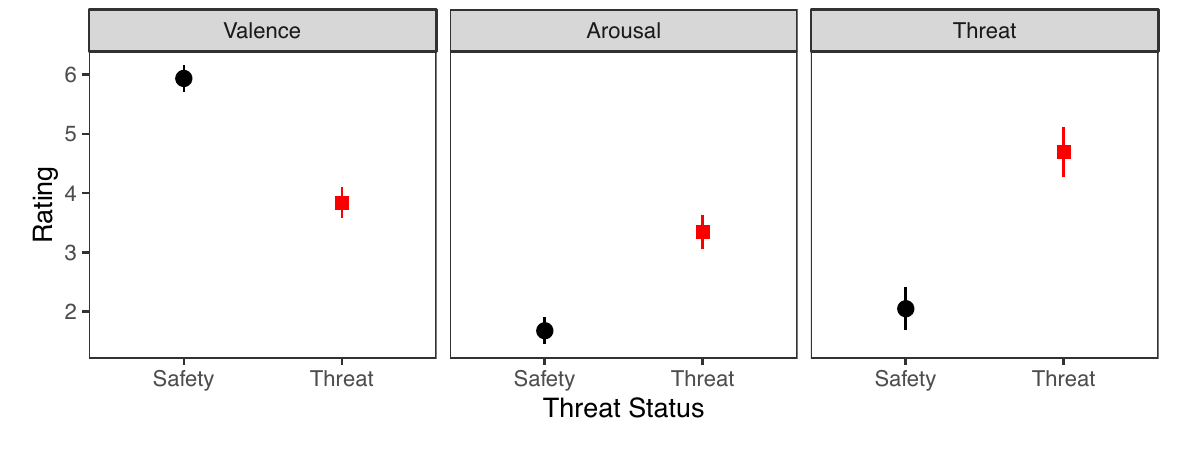
FIGURE 2 Mean ratings of valence, arousal, and threat for the assigned safety and threat colors. Bars indicate 90% confidence